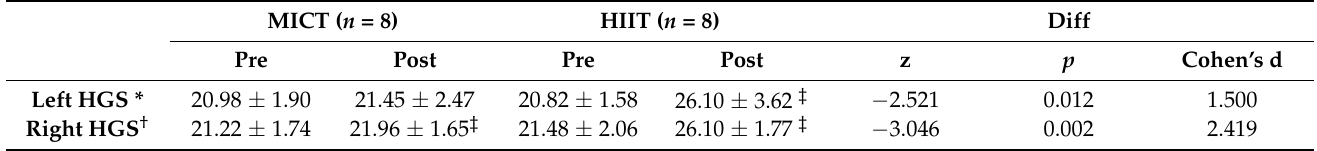
grip strength (left: z = − 2.251. p = 0.012, right: z = − 2.521. p = 0.012) (Table 6, Figure 3). Table 6. Responses on hand grip strength for MICT and HIIT groups. Table 6. Responses on hand grip strength for MICT and HIIT groups. Table 6. Responses on hand grip strength for MICT and HIIT groups.